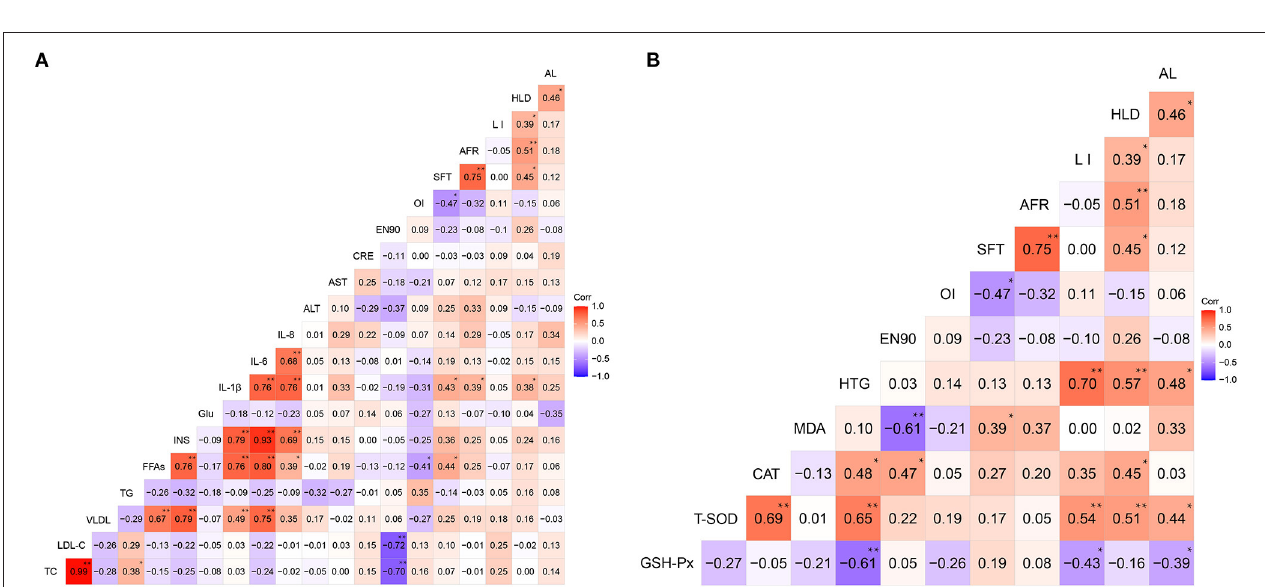
FIGURE 5 | The average number of eggs (A) and the egg-laying rate (B) of sample layers with different FMO3 genotypes from 19 to 90 weeks. FMO3 , flavin-containing monooxygenase 3. AA, AA genotype hens; AT, AT genotype hens; TT, TT genotype hens. Values are expressed as means ± standard deviation (SD); n = 9 hens with each genotype. Mean values with (*) differ significantly between the AA and TT hens ( P < 0.05).